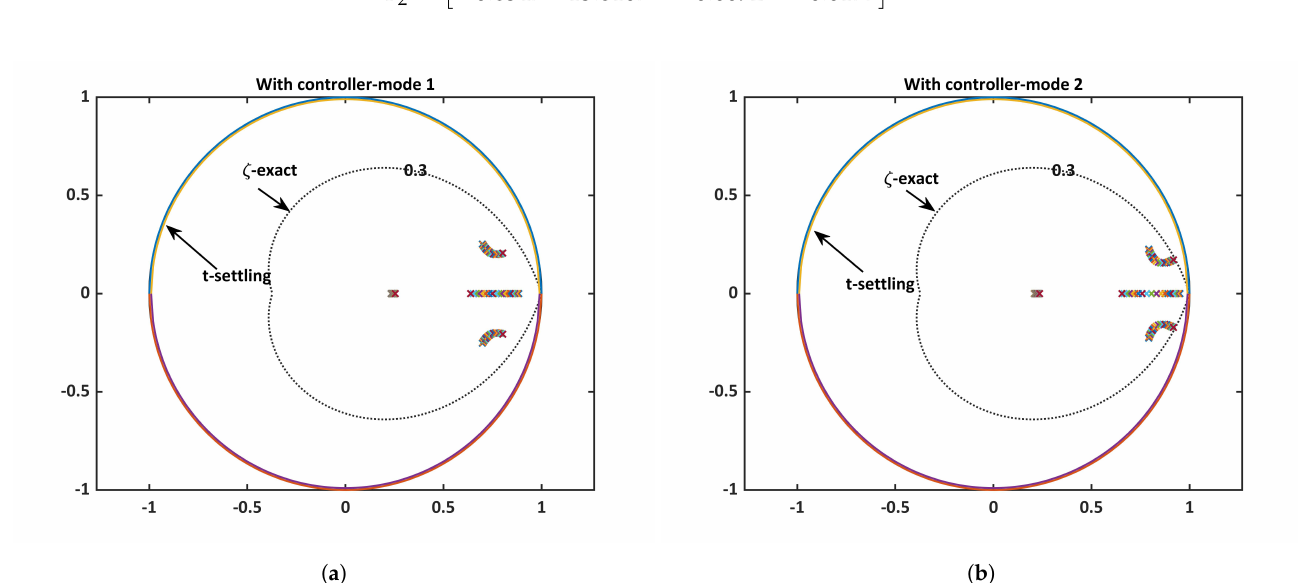
Figure 7. Closed-loop poles for different load changes, ( a ) mode 1 (maximum reliability) ( b ) mode 2 (minimum